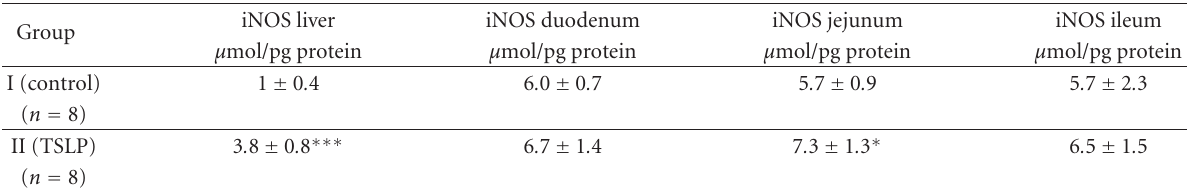
Table 5. Liver and intestinal inducible nitric oxide synthase (iNOS) activity in control rats (Group I) and in rats with triple stenosing ligation of portal vein (TSLP) (Group II) after 28 days of evolution. The results are represented as mean ± SD. ∗ denotes that P < . 05 and ∗∗∗ P < . 001 which is a statistically significant value in relation to the control group.